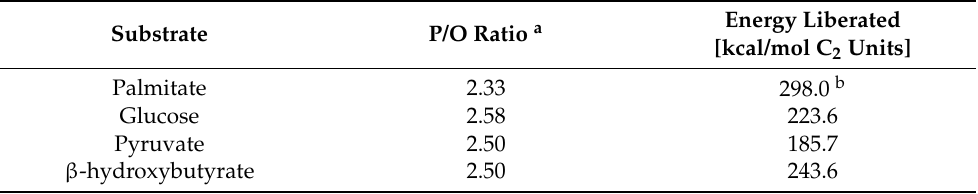
Table 1. The energy efficiency of non-nitrogenous energy substrates